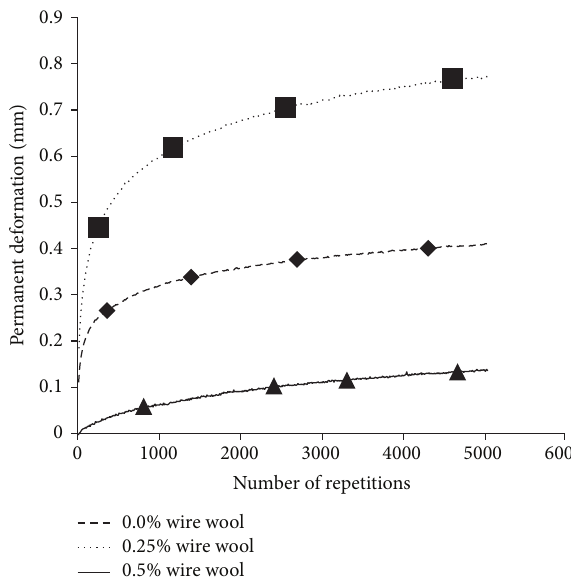
Figure 3: Creep behavior results for different HMA mixes.